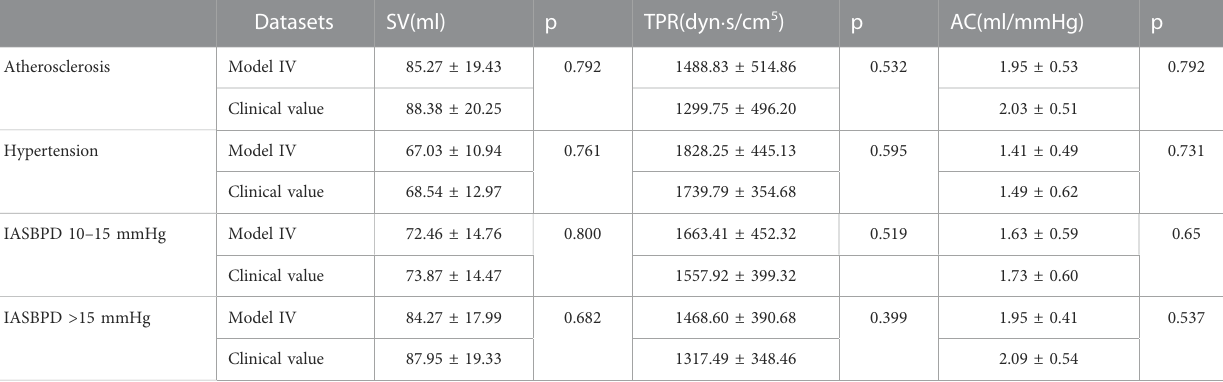
TABLE 3 Comparison calculation and clinical measurements value of SV, TPR, and AC with cardiovascular